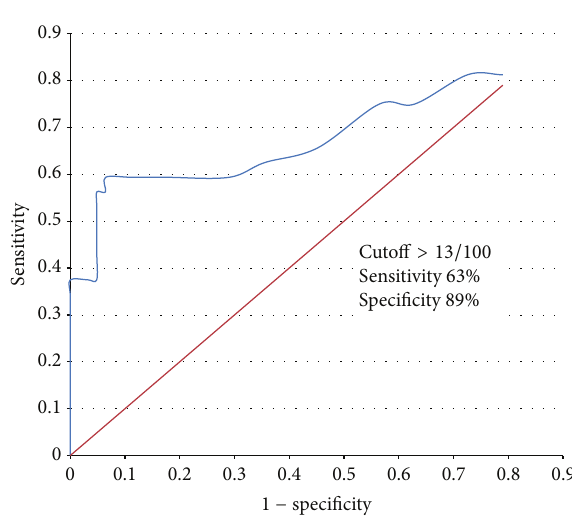
Figure 3: ROC analysis of overall adverse neonatal outcome according to NRBC cutoff of >